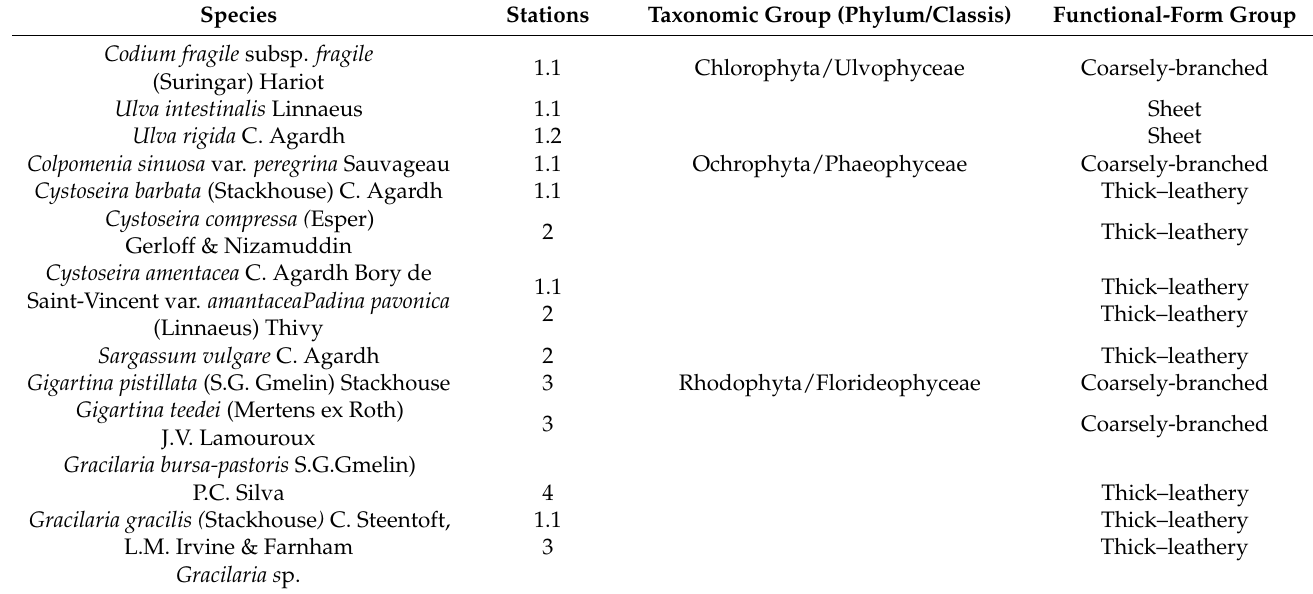
Table 1. Macroalgae species, stations of collection, and their taxonomic functional-form